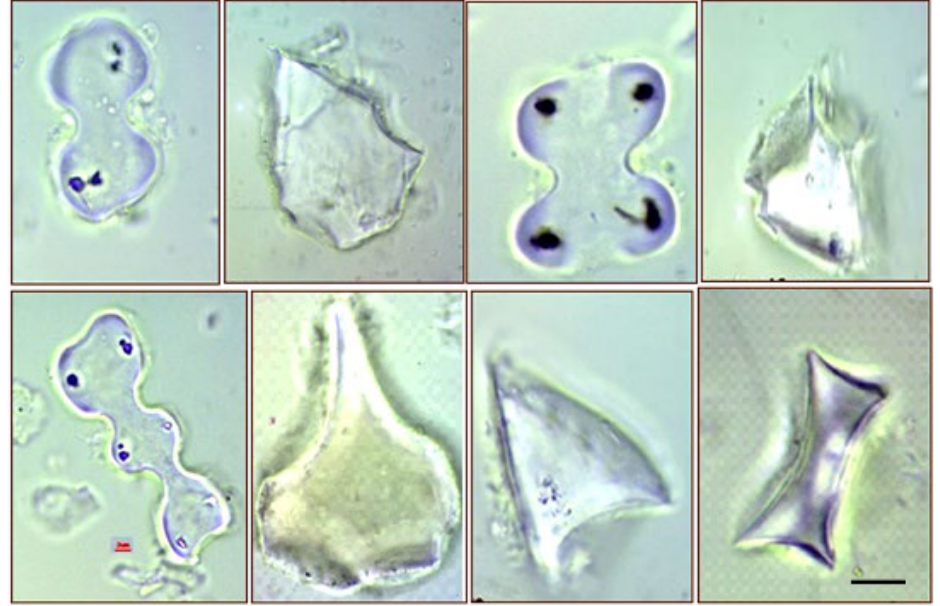
Figure 2. Some phytolith morphotypes of Arundo donax L. ecotypes (Photo: Dr. Szilvia Kovács). Upper line left to right: bilobate, blocky, cross, pyramidal, bottom line left to right: polylobate, bulliform, scutiform, rondel. Scale bar : 5 μm).